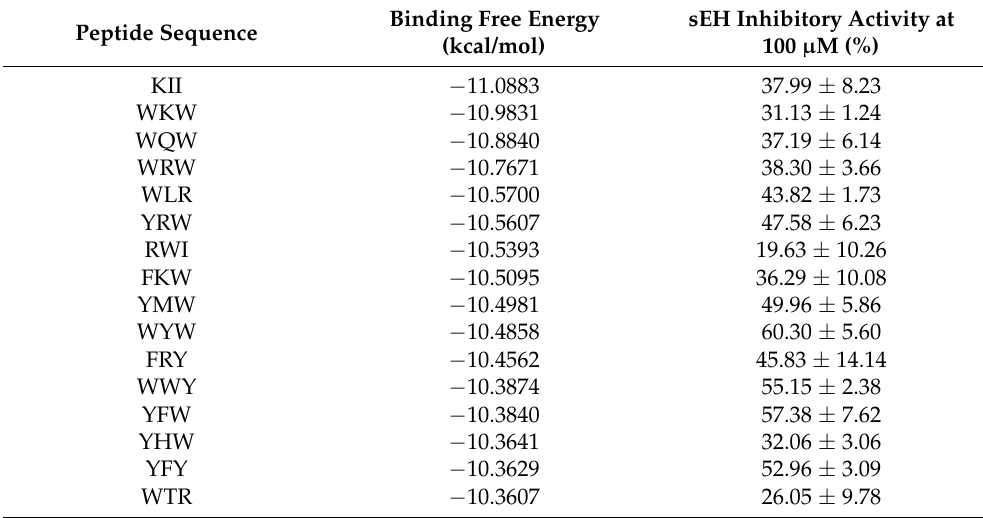
Table 1. The binding free energy of the top 20 tripeptides and 10 dipeptides and their sEH inhibitory